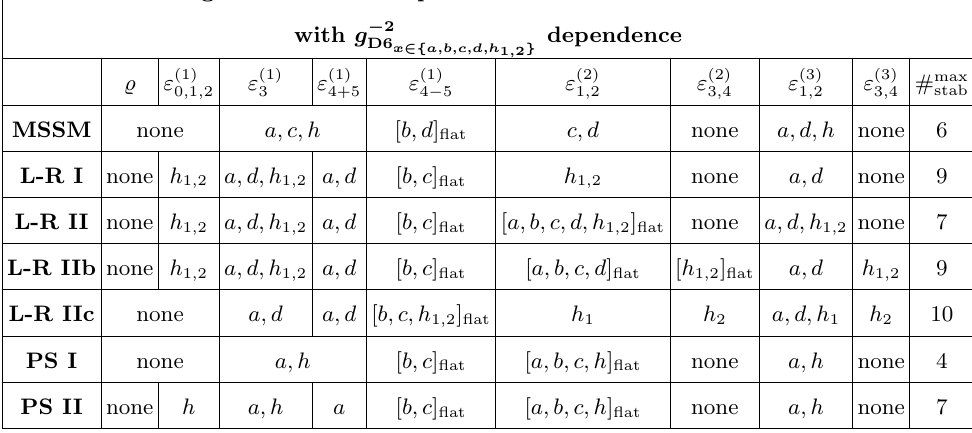
Table 12 . Counting of stabilised deformation moduli according to the orientifold-odd wrapping numbers displayed in table 11. The L-R symmetric model of prototype IIc presented in section 3.4 is expected to have the maximal number of ten out of 14 Z